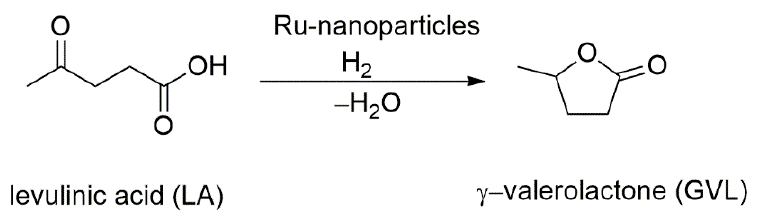
Figure 5. Metal complexes of NHC ‐ NH 2 chelates [134–139].